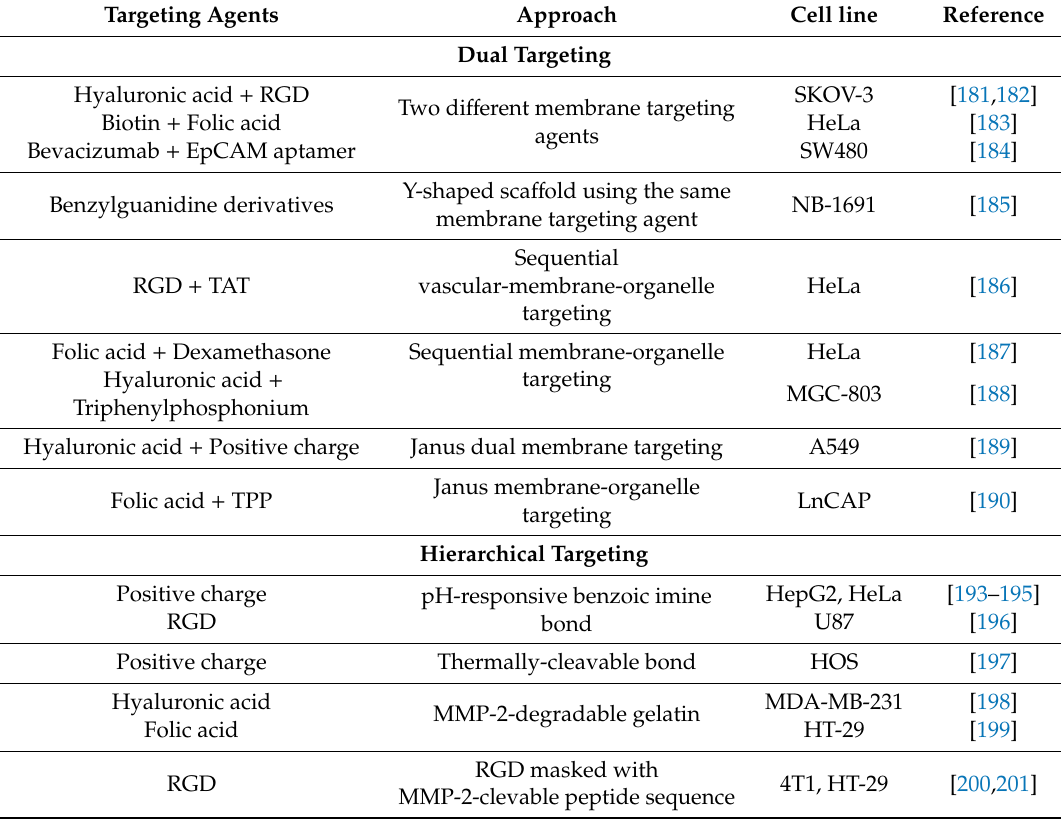
Table2. SummaryofthedifferentstrategiesimplementedintoMSNsforachievingdualorhierarchicaltargeting. Targeting